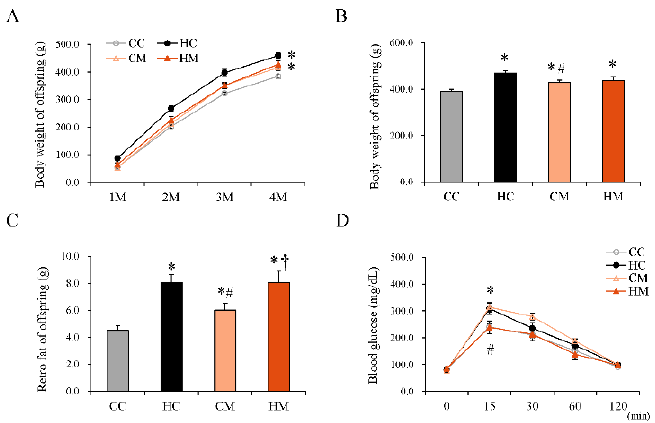
Figure 7. Physiological characteristics of 120-day-old offspring fed a maternal control diet (CC), maternal high-fat diet (HC), maternal control diet with maternal metformin treatment after mating (CM), or maternal high-fat diet with maternal metformin treatment after mating (HM). ( A ) Body weight (BW) change; all the offspring received a control diet after weaning. A significant increase in BW was observed at 4 months of age. Detailed BW data are presented in Supplementary Table S4. ( B ) BW of offspring at 120 days of age. ( C ) Weight of retroperitoneal fat depot. ( D ) Intraperitoneal glucose tolerance test (IPGTT) data. Detailed blood sugar and area under the curve (AUC) data are presented in Supplementary Table S5. The results are presented as mean ± standard error. * Compared to the CC group, p < 0.05; # compared to the HC group, p < 0.05; † compared to the CM group, p < 0.05.